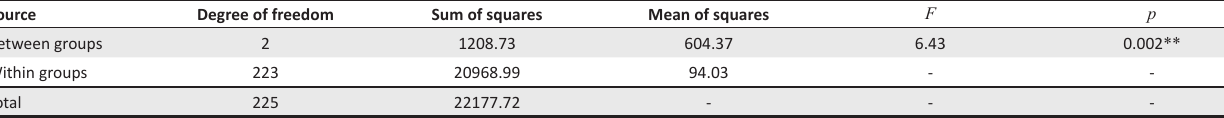
TABLE 7: One-way analysis of variance of Attitudes Toward Suicide Scale scores in levels of irritation. Source Within groups